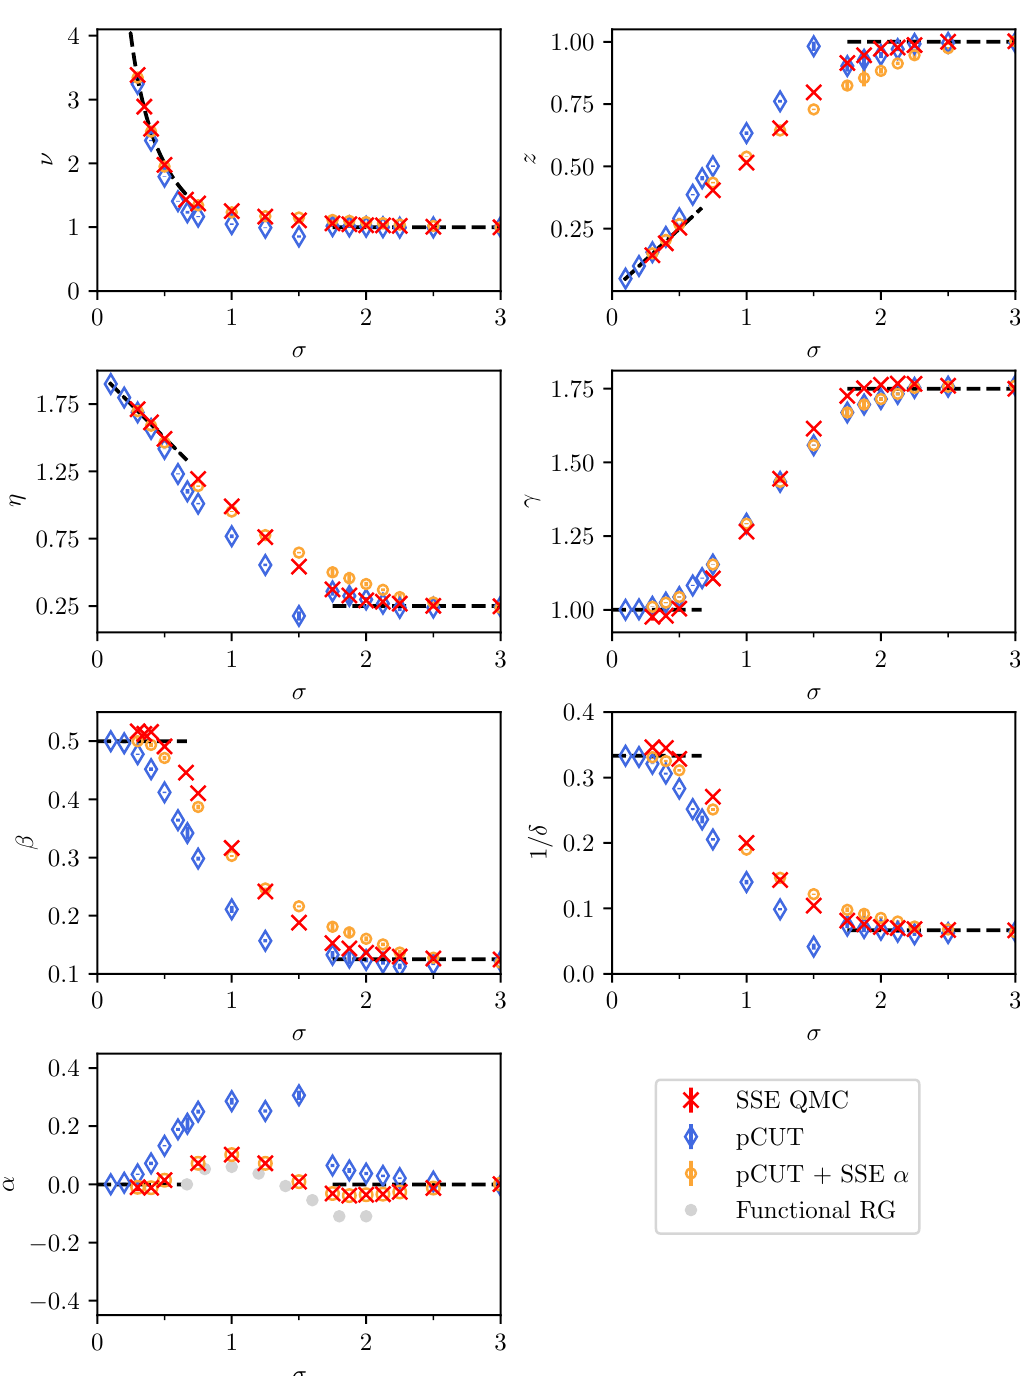
Figure 3: Full set of critical exponents as a function of the decay parameter σ ex- tracted by SSE ( × ), pCUT ( ◊ ), and pCUT with the α from SSE ( ◦ ). The predic- tions for the long-range mean-field and short-range criticality are depicted by black dashed lines for σ < 2 / 3 and σ > 2 − η respectively. For α , we additionally SR added converted data from functional RG (see Ref. [ 53 ] , • ) to compare the bump in the intermediate regime. The raw data used to extract the exponents and the numerical values of the critical exponents are provided in Ref. [ 71 ]